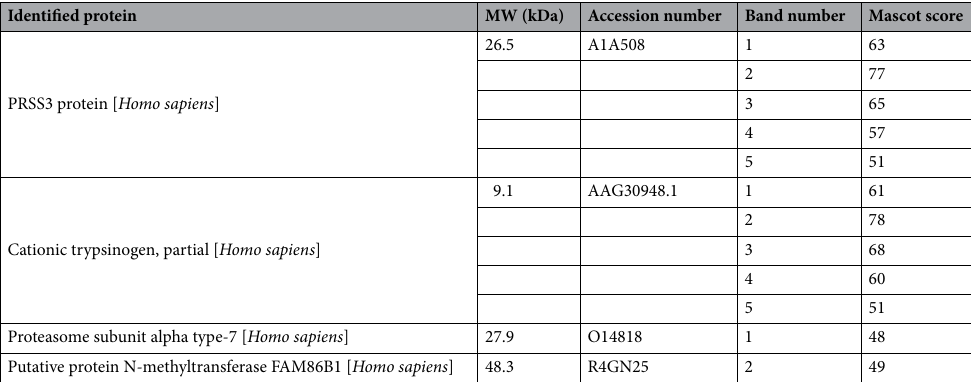
Table 1. List of the proteins identified by LC-MS/MS.